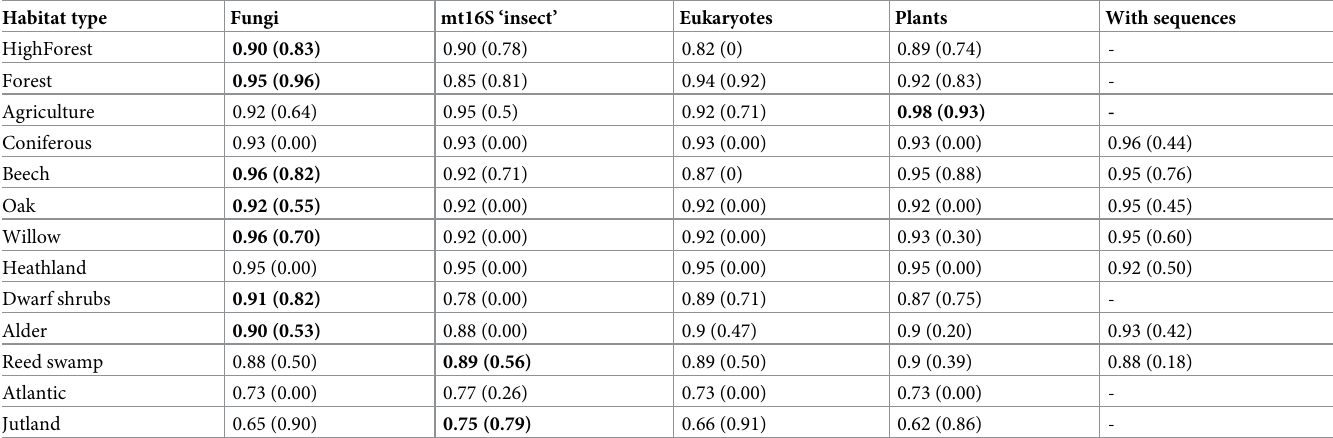
Table 3. Predicting habitat types from variation in soil